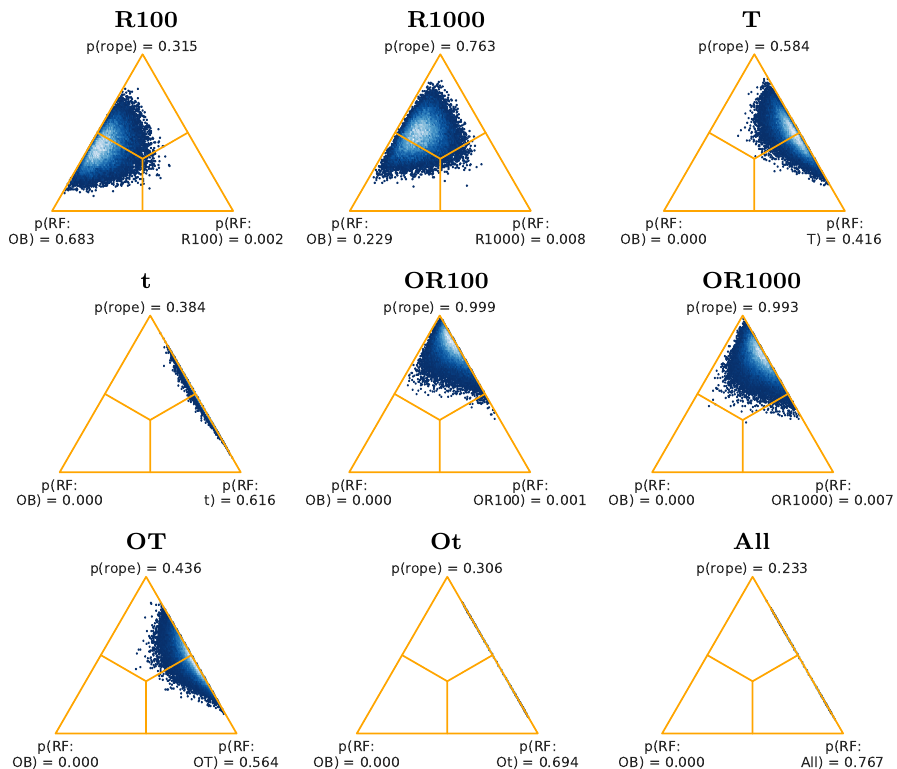
Figure 6. Posteriors for the Bayesian sign-rank tests for RF, from all the datasets.